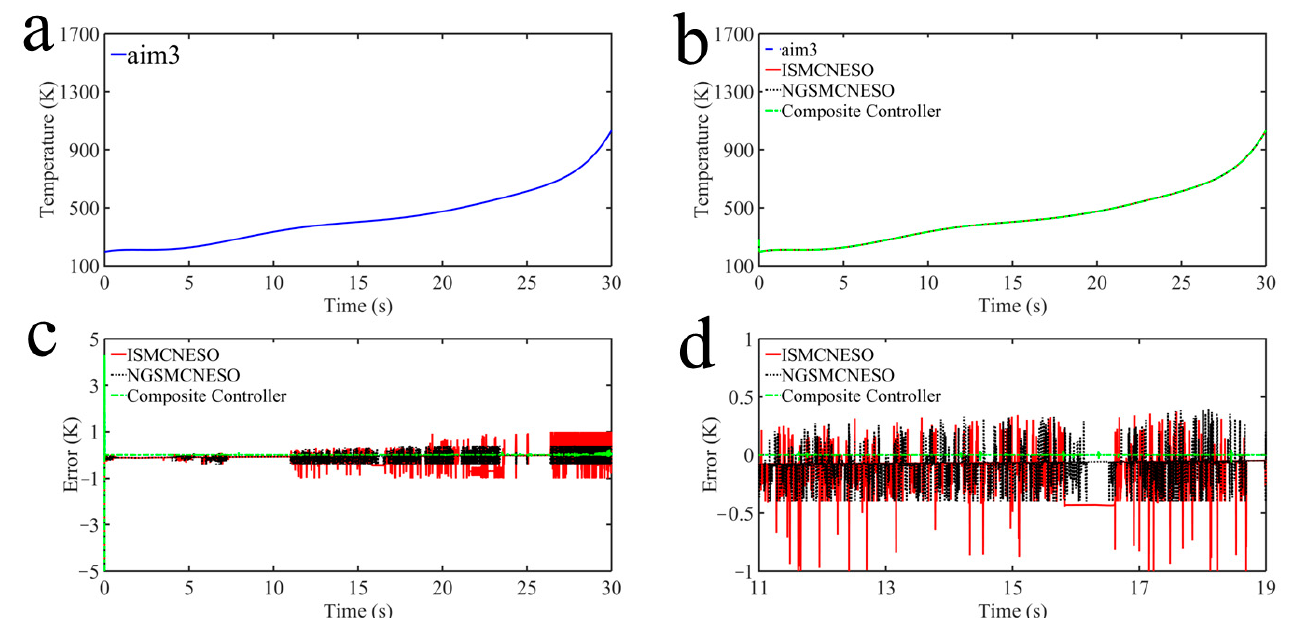
Figure 16. Simulation results: ( a ) the fitting curve of the reference temperature trajectory from Wall 0_6 mm; ( b ) the reference temperature tracking performance among ISMCNESO controller, NGSMCNESO controller, composite controller; ( c ) the tracking errors; ( d ) their partial enlarged figures in details.